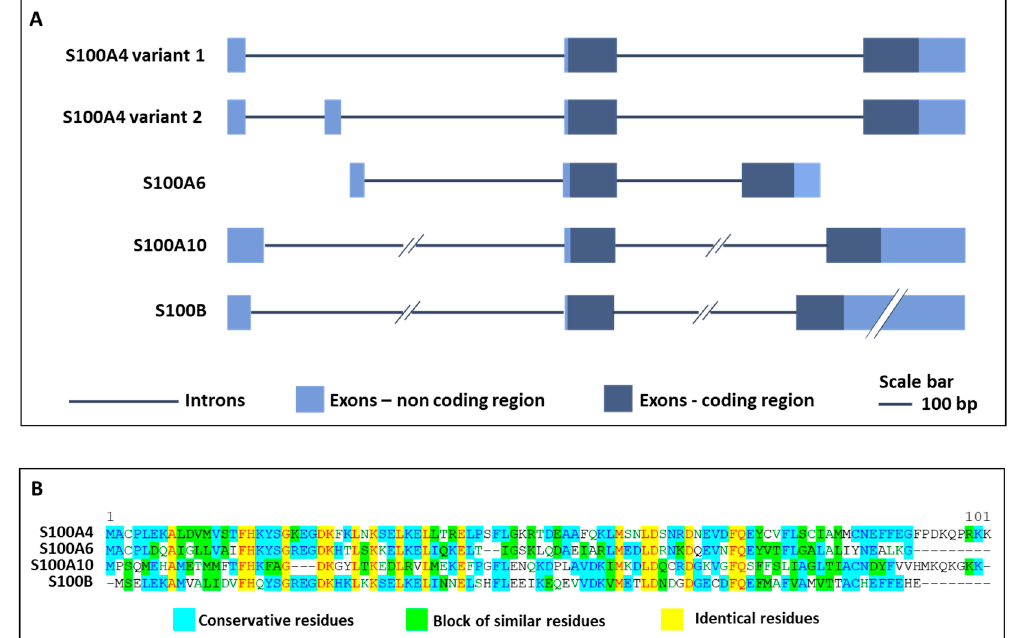
Figure 1. Exon-intron organization and protein sequence comparison of S100A4, S100A6, S100A10 and S100B. The figure shows the exon-intron organization ( A ) and the protein sequence comparison ( B ) of S100A4, S100A6, S100A10 and S100B, S100 family members mainly involved in nervous system diseases.